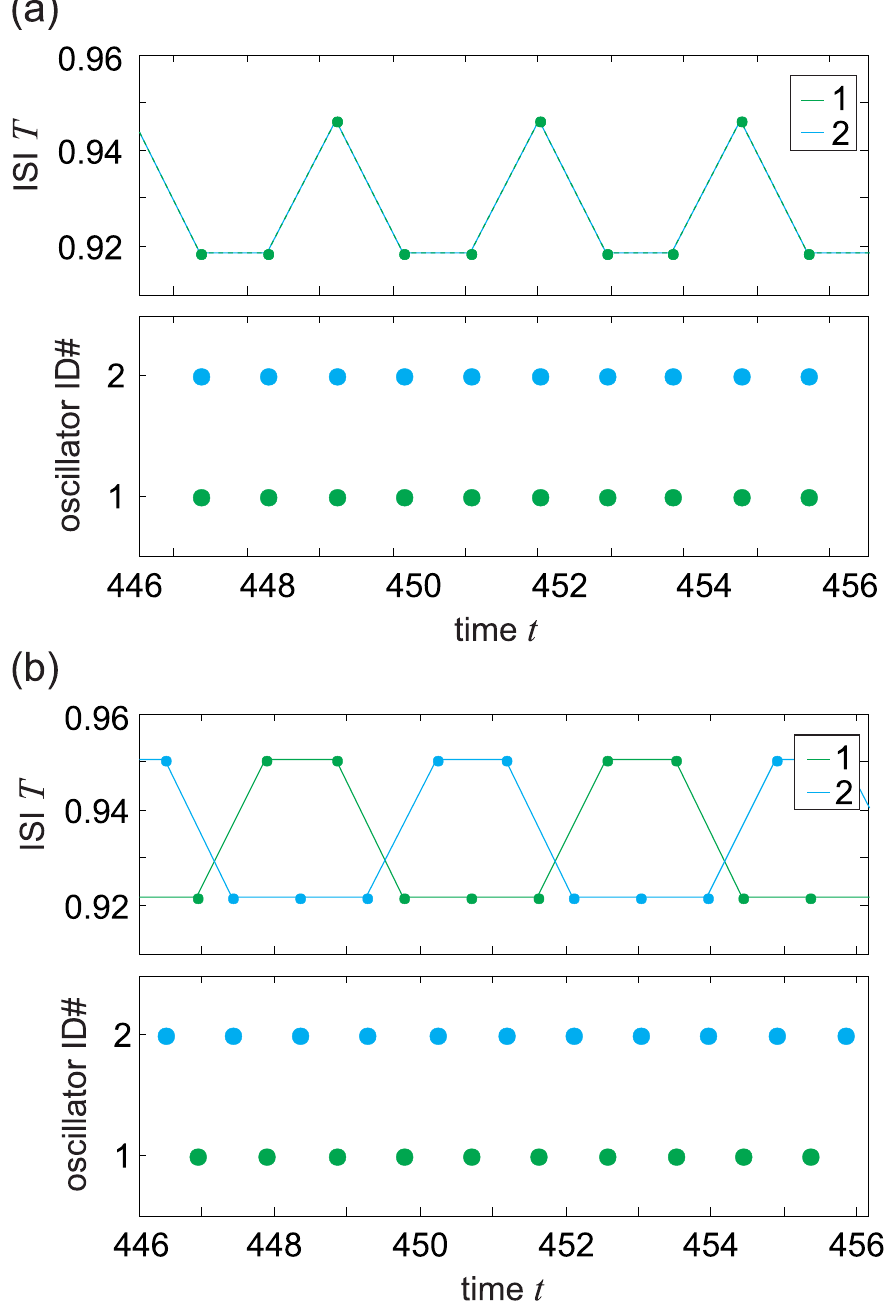
Fig. 4 Examples of jittering regimes of two oscillators: (a) antiphase jittering at τ = 1 . 95 and (b) in-phase jittering at τ = 2 . 4. The upper panels show the temporal dynamics of the ISIs for both oscillators, the bottom panels show the moments of spike emission. Note that in the case of in-phase jittering the ISIs for the both oscillators coincide, which means that they remain fully